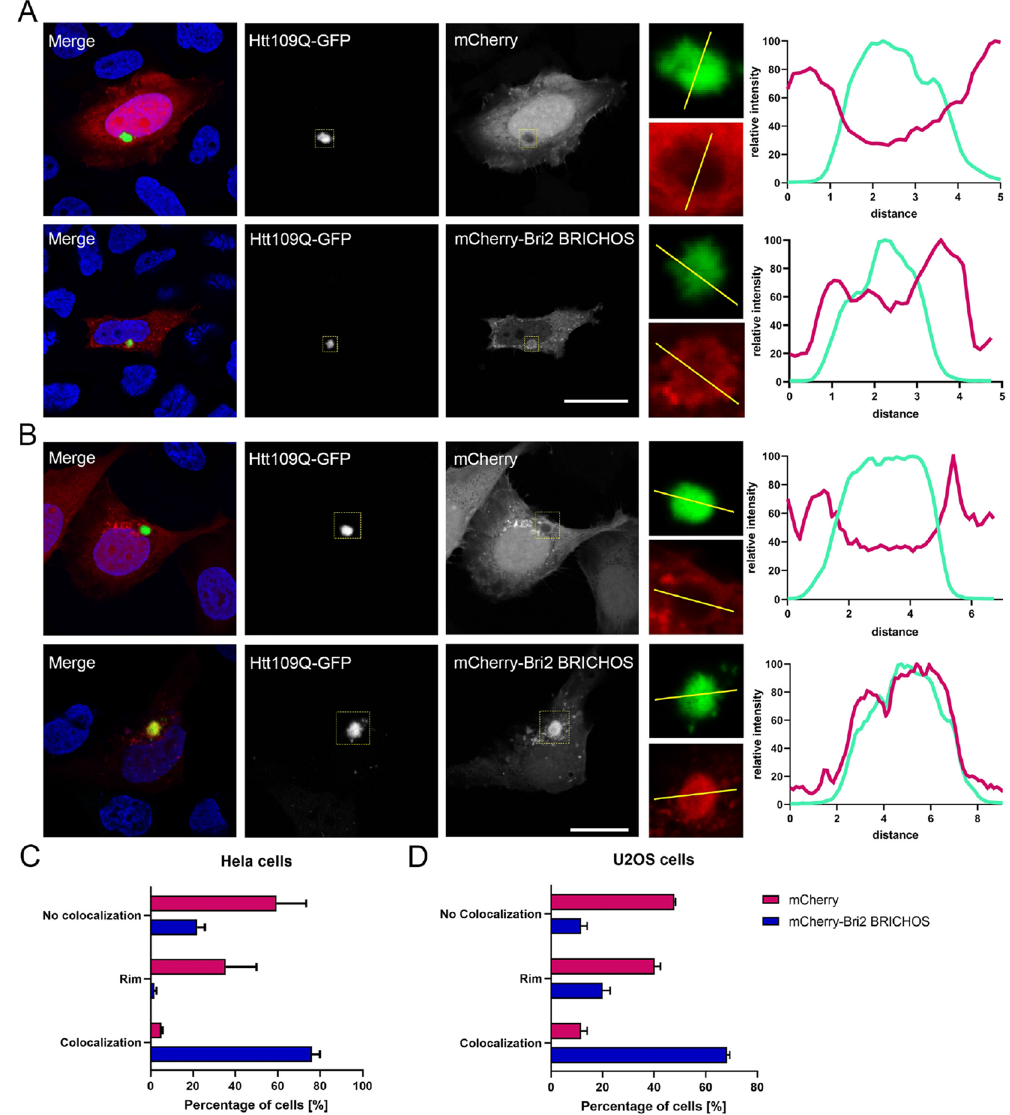
Figure 2. mCherry-Bri2 BRICHOS co-localizes with Htt aggregates. ( A , B ) Htt109Q-GFP was transiently co-transfected with either mCherry-Bri2 BRICHOS or mCherry into Hela ( A ) or U2OS ( B ) cells. Cells were fixed 48 h after transfection and chromatin was stained with Hoechst. Line scans through Htt-aggregates show mCherry-Bri2 BRICHOS and mCherry (red) localization at the aggregates (green). Scale bar 20 µm. Manual quantification of localization of mCherry-Bri2 BRICHOS and mCherry at Htt aggregates in Hela ( C ) and U2OS ( D ) cells. Data are presented as mean + SEM of three independent